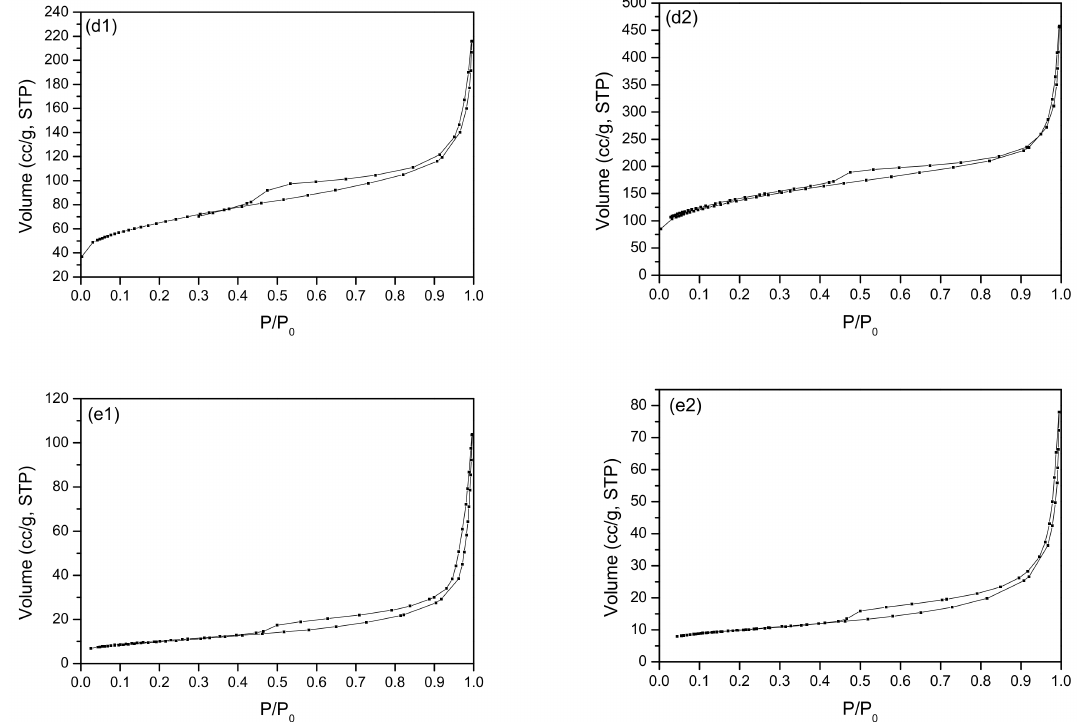
Figure 7. Nitrogen adsorption-desorption isotherm of ( a1 ): Co/CNT, ( a2 ): CNT, ( b1 ): Co/AC, ( b2 ): AC, ( c1 ): Co/GO, ( c2 ): GO, ( d1 ): Co/rGO, ( d2 ): rGO, ( e1 ): Co/CNF, ( e2 ): CNF.